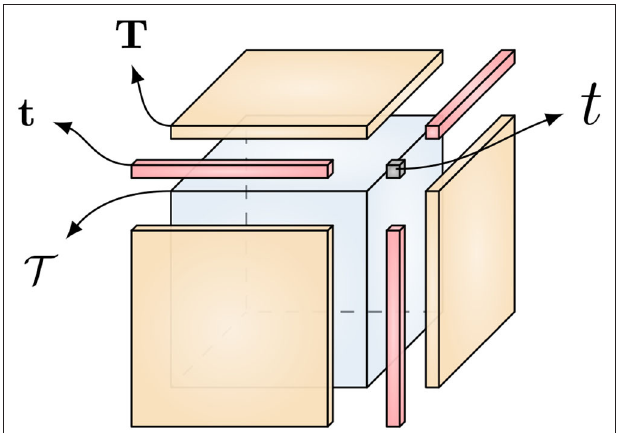
FIGURE 2 | By applying the homogenization process, symmetric tensors can represent the coefficients of non-homogeneous polynomials. For example, by stacking the coefficients t , t , T , and T of the third degree polynomial into a tensor as shown above, we can represent it with a symmetric third-order tensor. Image reproduced from Debals [